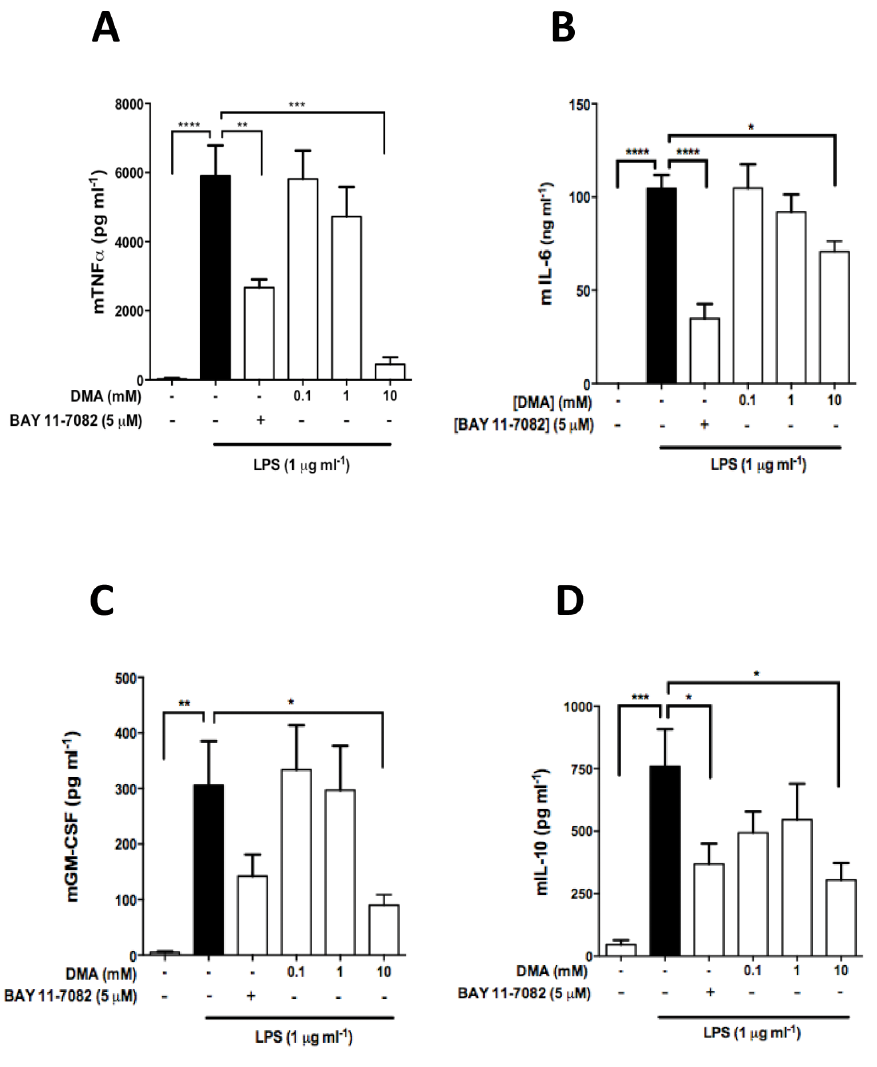
Figure 2. DMA inhibits cytokine and chemokine secretion in LPS-stimulated RAW 264.7 cells. ELISA was performed to determine (A) TNF α , (B) IL-6, (C) GM-CSF and (D) IL-10 levels in RAW 264.7 cell culture supernatant after incubation with DMA and BAY 11-7082 in the presence of LPS after 24 h. Data shown are means ± SEM of at least three independent experiments done in duplicate. * P ≤ 0.05; ** P ≤ 0.01; *** P ≤ 0.001; **** P ≤ 0.0001.